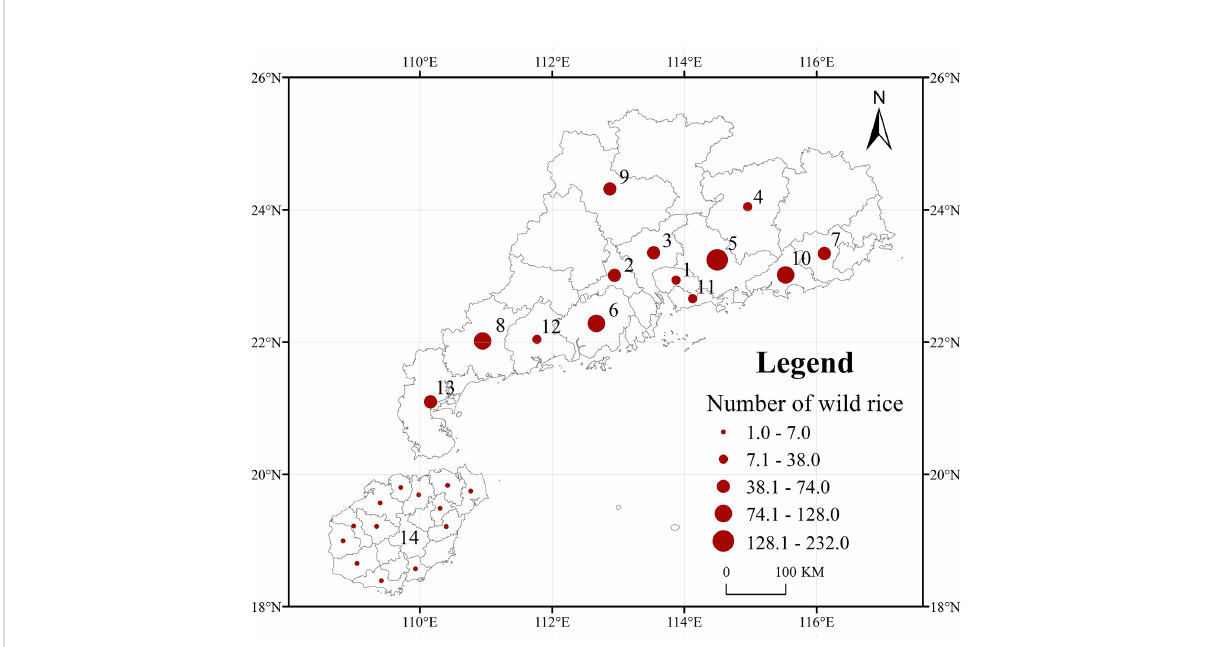
FIGURE 1 Ecogeographical distribution of 998 representative O. ru fi pogon accessions in Guangdong and Hainan Provinces, China. The circle size indicates the relative sampling number from each region. 1: Dongguan, 2: Foshan, 3: Guangzhou, 4: Heyuan, 5: Huizhou, 6: Jiangmen, 7: Jieyang, 8: Maoming, 9: Qingyuan, 10: Shanwei, 11: Shenzhen, 12: Yangjiang, 13: Zhanjiang; 14: